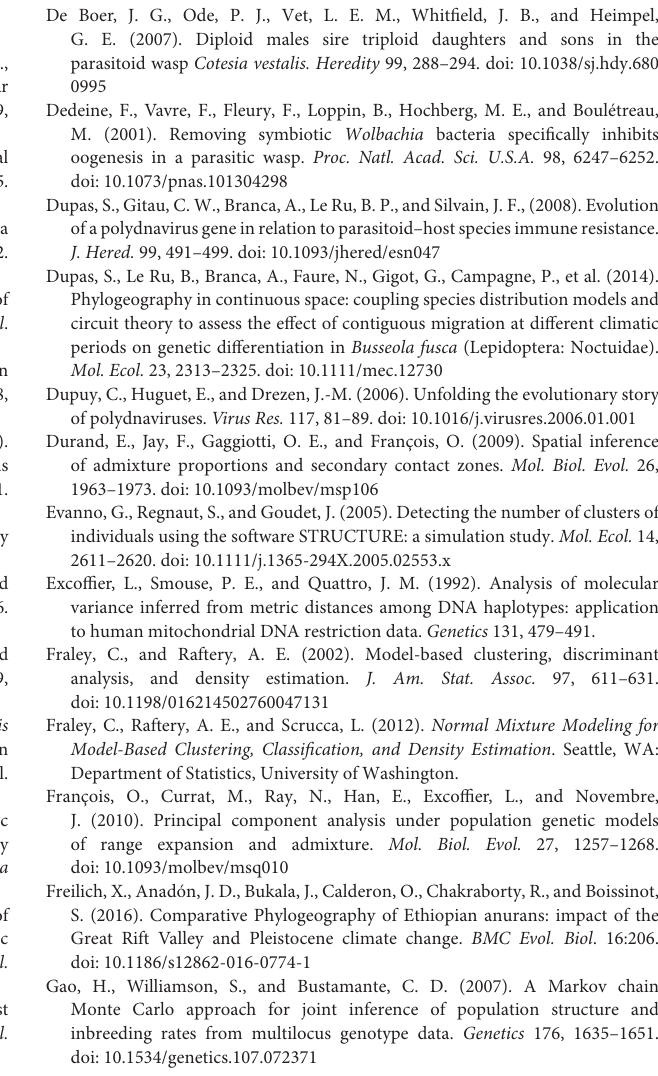
Figure S1 | Delta-K of Evanno et al. (2005) for the Instruct inference of Cotesia sesamiae population genetic structure. Figure S2 | Köppen-Geiger climate across Sub-Saharan Africa (Af, Tropical Rainforest; Am, Tropical Monsoon; Aw, Tropical Savannah; BSh, Hot Arid Steppe; BSk, Cold Arid Steppe; BWh, Hot Arid Desert; BWk, Cold Arid Desert; Csa, Temperate with Hot and Dry Summer; Csb, Temperate with Warm and Dry Summer; Cwa, Temperate with Dry Winter and Hot Summer; Cwb, Temperate with Dry Winter and Warm Summer; Cfa, Temperate without Dry Season and Hot Summer; Cfb, Temperate without Dry Season and Warm Summer). Figure S3 | Distribution of genetic clusters of Cotesia sesamiae wasps for DAPC with K = 5 (A) , TESS3 software (B) and the Instruct software CLUMPP consensus with K = 5 (C) . For each clustering method, only individual with posterior probability of assignment above 0.5 are represented for each analysis. Distribution in Sub Saharan Africa is represented at the top and a zoom in Kenya at the bottom. Table S1 | List of field collected Cotesia sesamiae wasp samples and associated geographic and ecological